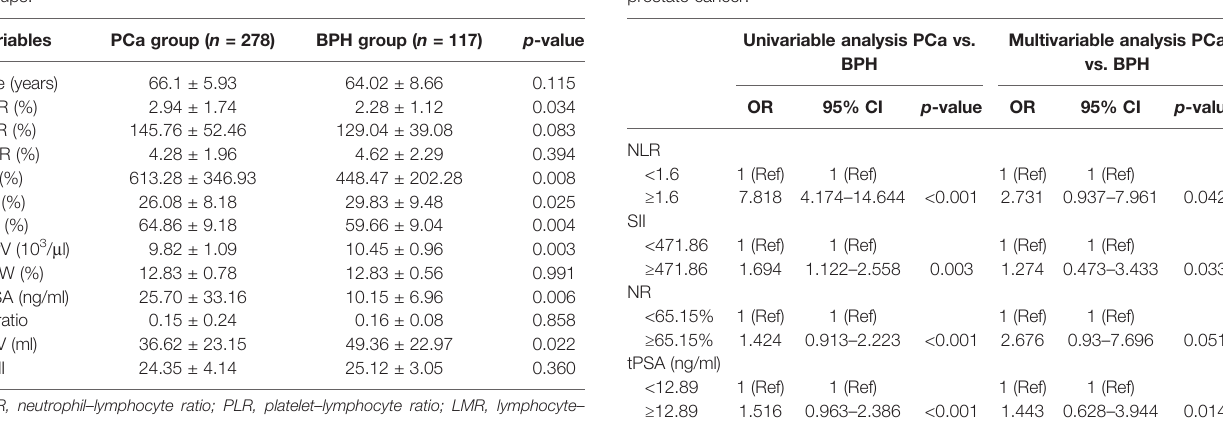
TABLE 1 | Comparison of clinical and CBC-based parameters with respect to groups.